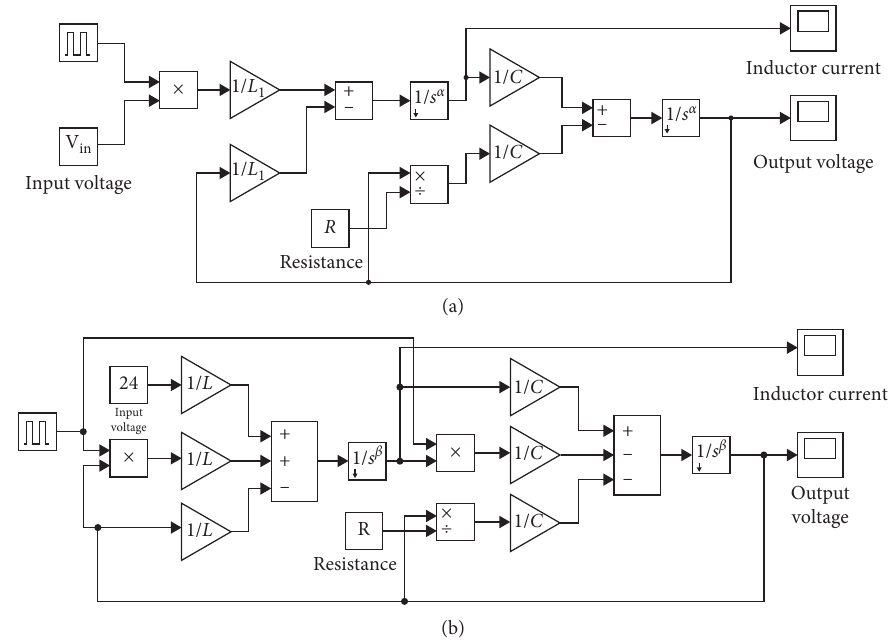
Figure 5: Fractional-order simulation of equivalent DC-DC converter: (a) Buck converter; (b) Boost